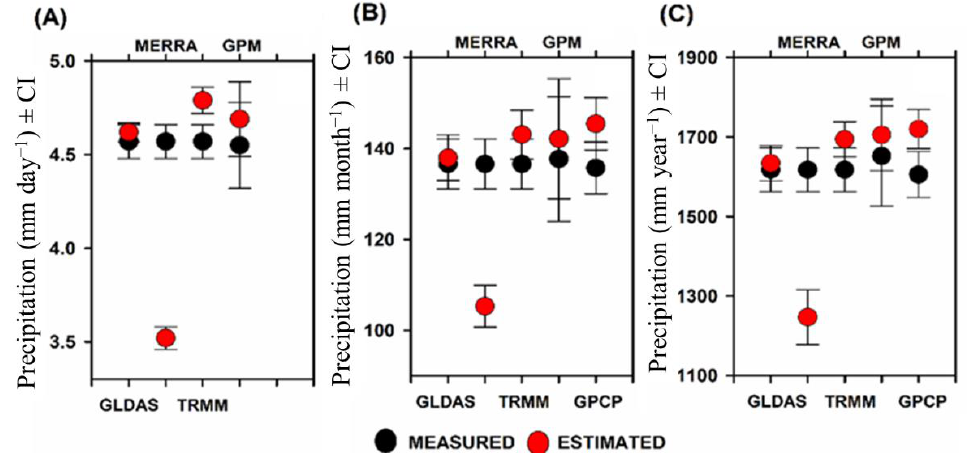
Figure 3. Averages values with the corresponding ± Confidence Interval (CI) of ( A ) daily (mm day − 1 ), ( B ) monthly (mm month − 1 ), and ( C ) annual (mm year − 1 ) precipitation as measured by conventional weather stations and estimated by GLDAS, MERRA, TRMM, GPM, and GPCP products in the state of Mato Grosso, Brazil. For ( A ), the daily values for the entire study period were averaged, while for ( B ), the monthly values for all months during the study period were averaged, and the annual values in ( C ) were the annual values averaged for all years during the study period.